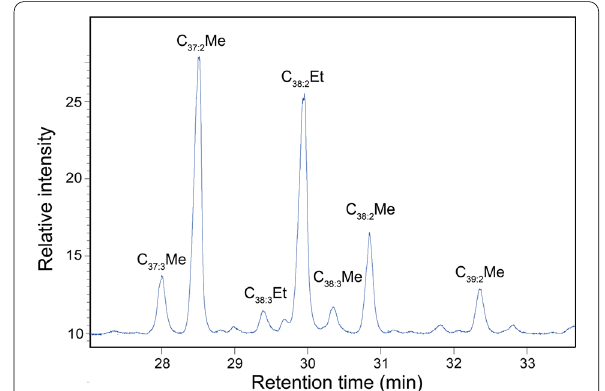
Fig. 3 Partial GC chromatogram of LCAs detected from the core GS-UR-1. The sample depth was 99.38–99.40 m, corresponding to the Jizodo